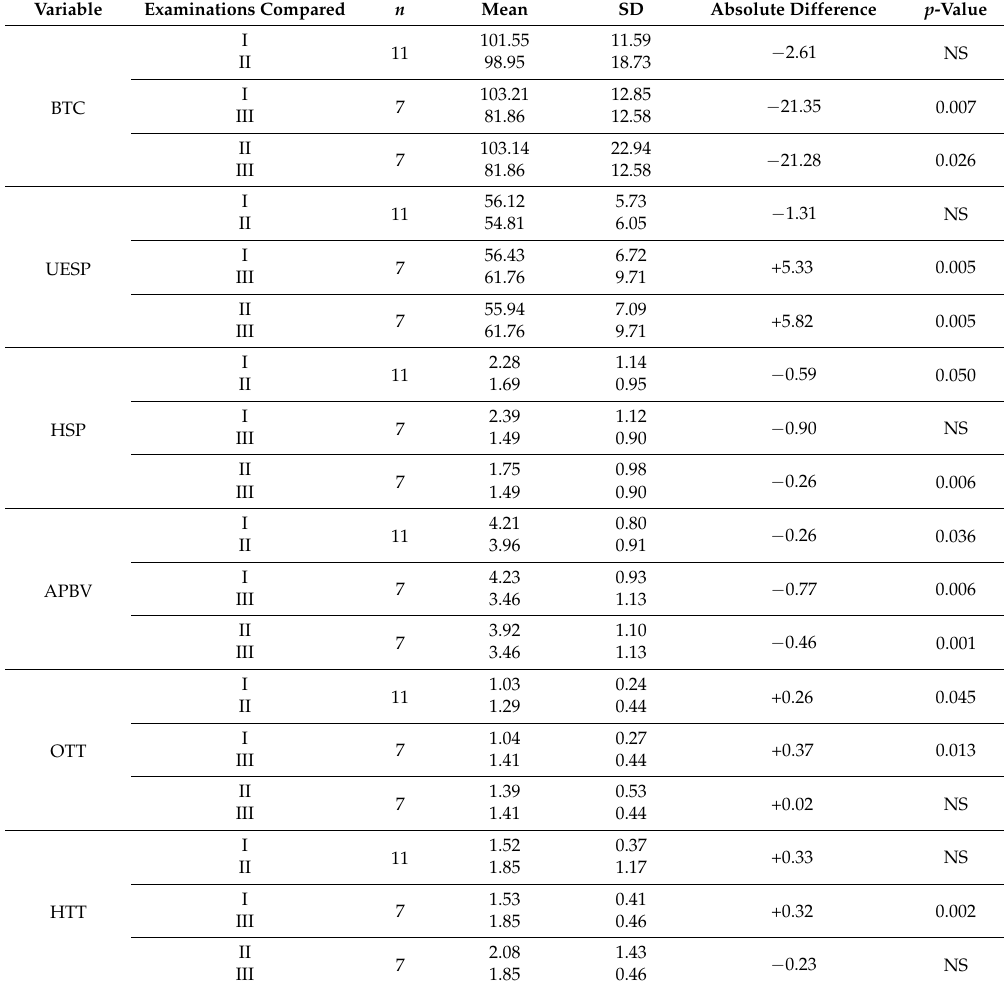
Table 3. Progression of swallowing difficulties among patients with amyotrophic lateral sclerosis— dry swallowing. Variable Examinations Compared n Mean SD Absolute Difference p